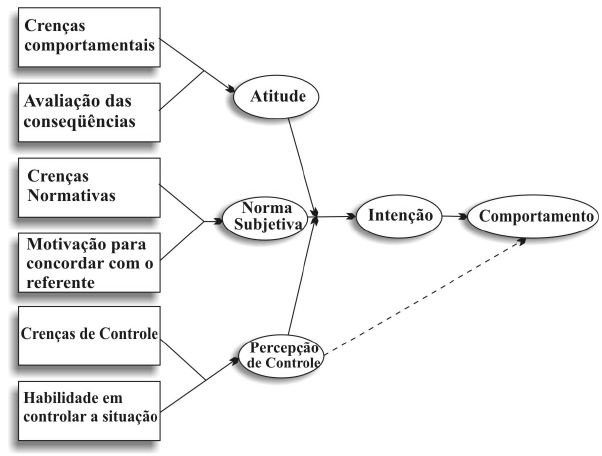
Figura 1. Modelo da Teoria da Ação Planejada (Ajzen,